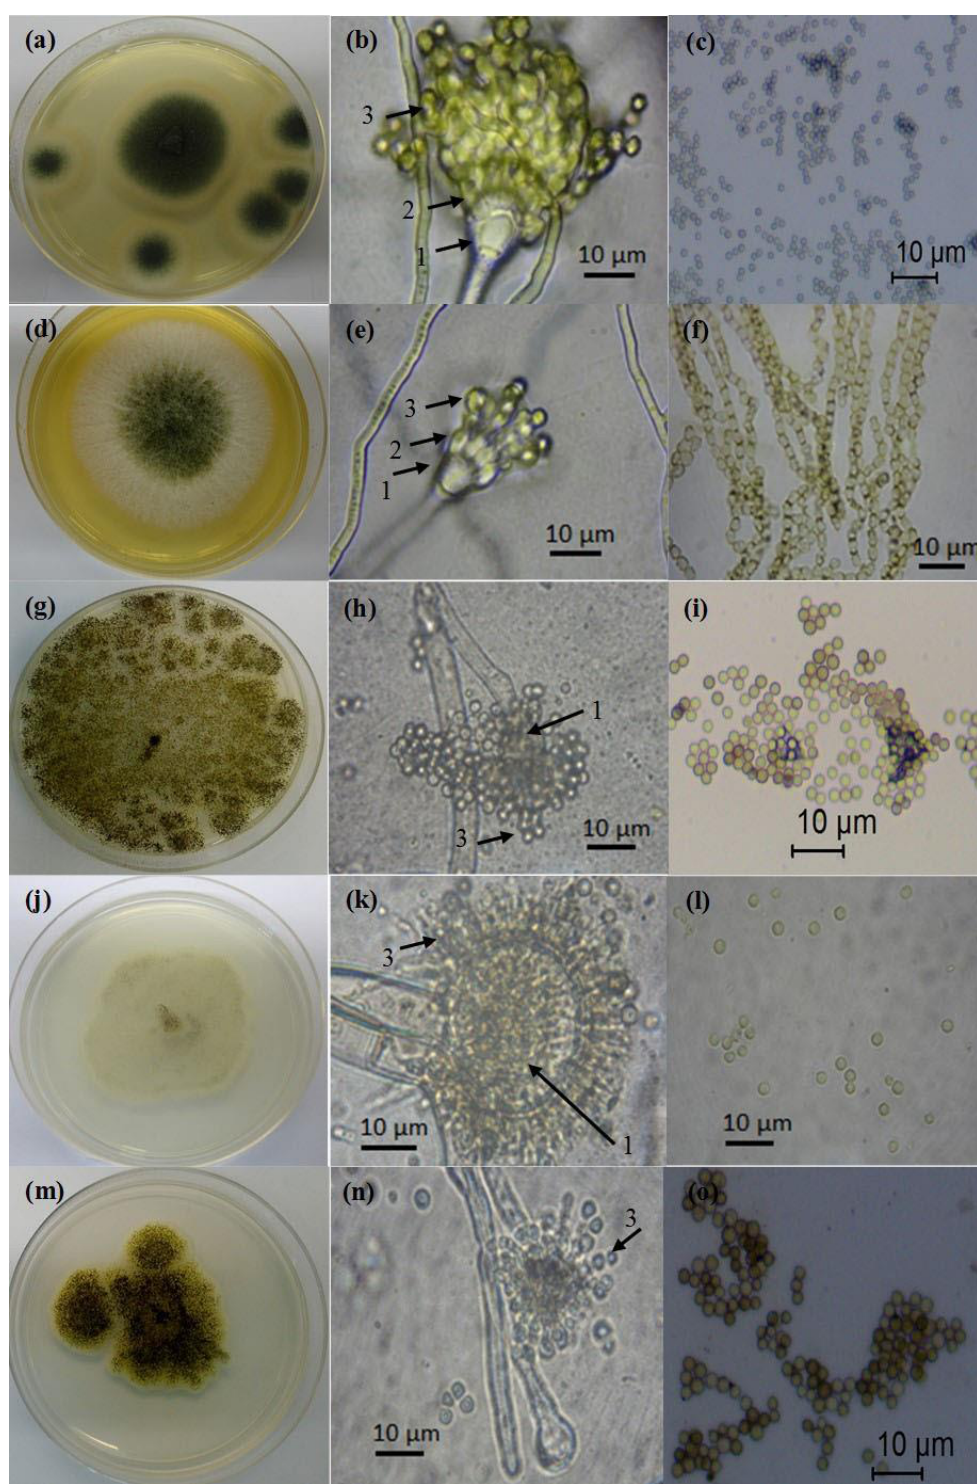
Figure 2 (Part 1). Macroscopic and microscopic characteristics of isolated fungi from Alan Bunga peat swamp forest ecosystems. Aspergillus fumigatus :- a) Colony appearance on potato dextrose agar (PDA); b) Conidia formed at the tip of conidiophore, vesicle, phialides; c) Conidia; Aspergillus flavus :- d) Colony appearance on PDA; e) Conidiophore, vesicle, phialides; f) Conidia; Aspergillus niger :- g) Colony appearance on PDA; h) Conidia formed at the tip of conidiophore, spore mass, vesicle, phialides; i) Conidia; Aspergillus tubingensis :- j) Colony appearance on PDA; k) Conidiophore, vesicle, phialides; l) Conidia; Aspergillus sp.:- m) Colony appearance on PDA; n) Conidia formed at the tip of conidiophore, spore mass, vesicle, phialides; o) Conidia. Arrows indicate: 1) vesicle; 2) phialides; 3) conidia